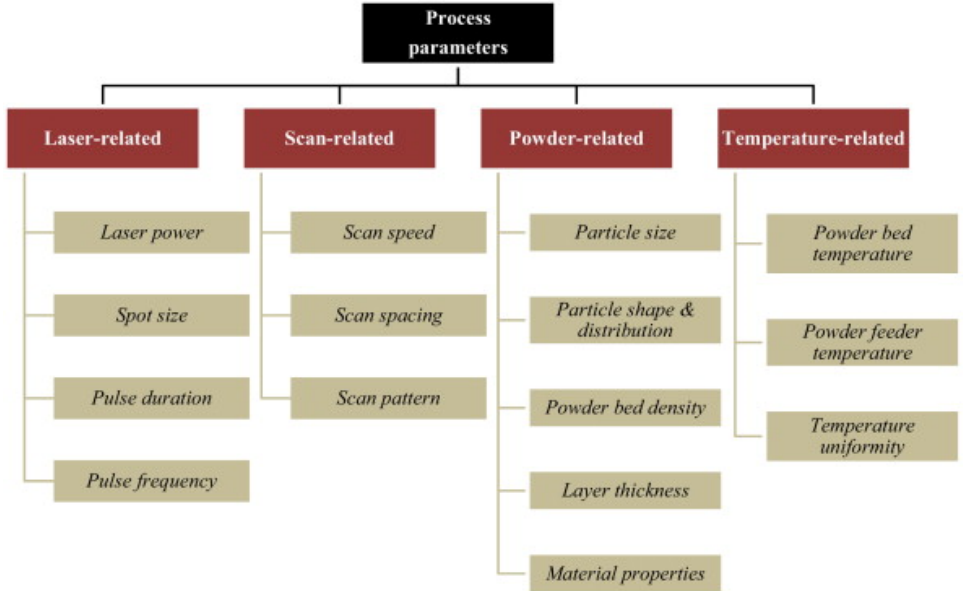
Figure 7. Controllable processing parameters in the LPBF process, which influence the final quality of the product [87].